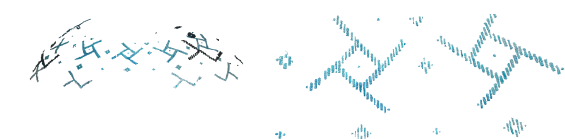
Figure 4. An example of a generated mask for the İnce Minareli Madrasa dome with the erroneous topmost circle.